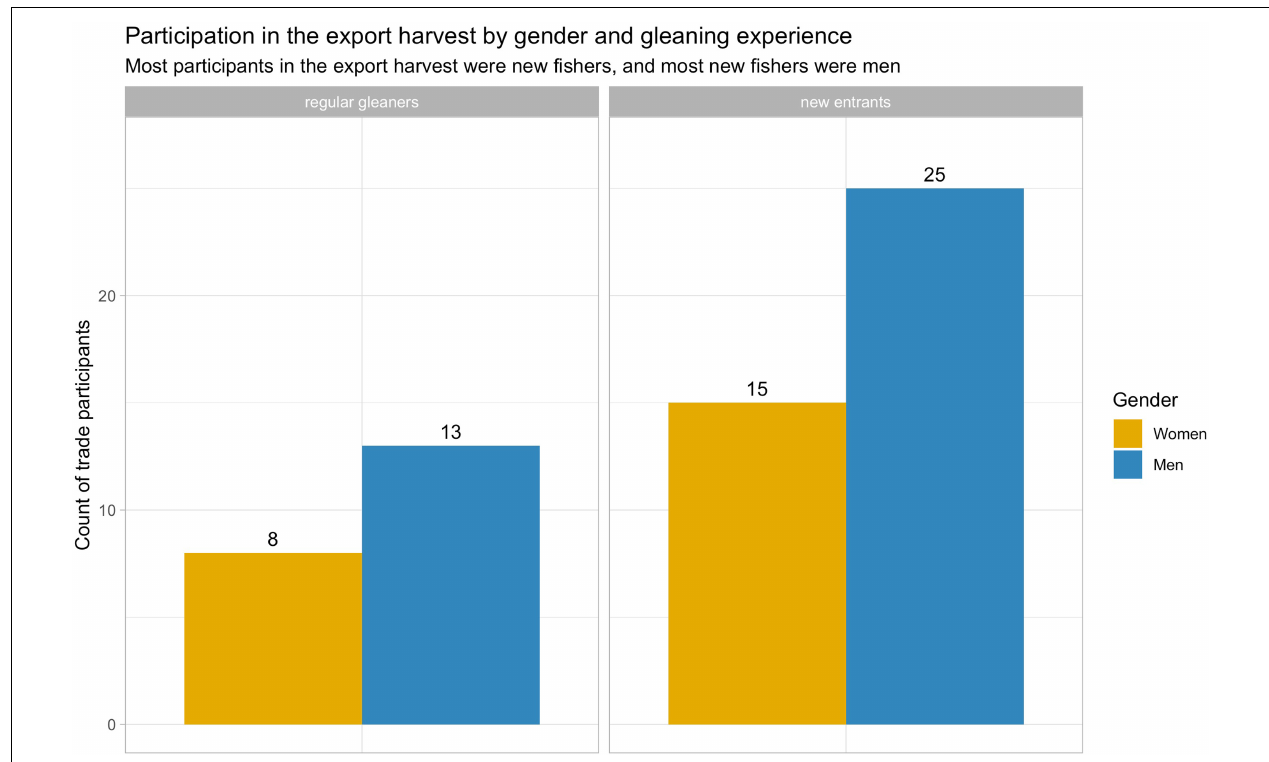
FIGURE 2 | Most fishers who participated in the trade were new entrants, and most new entrants were men. Whether or not a regular gleaner participated in the trade depended on their gender, with men gleaners more likely to participate.